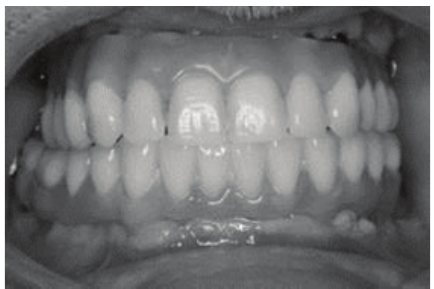
Figure 4: Installation of mandibular implant-supported prosthesis.